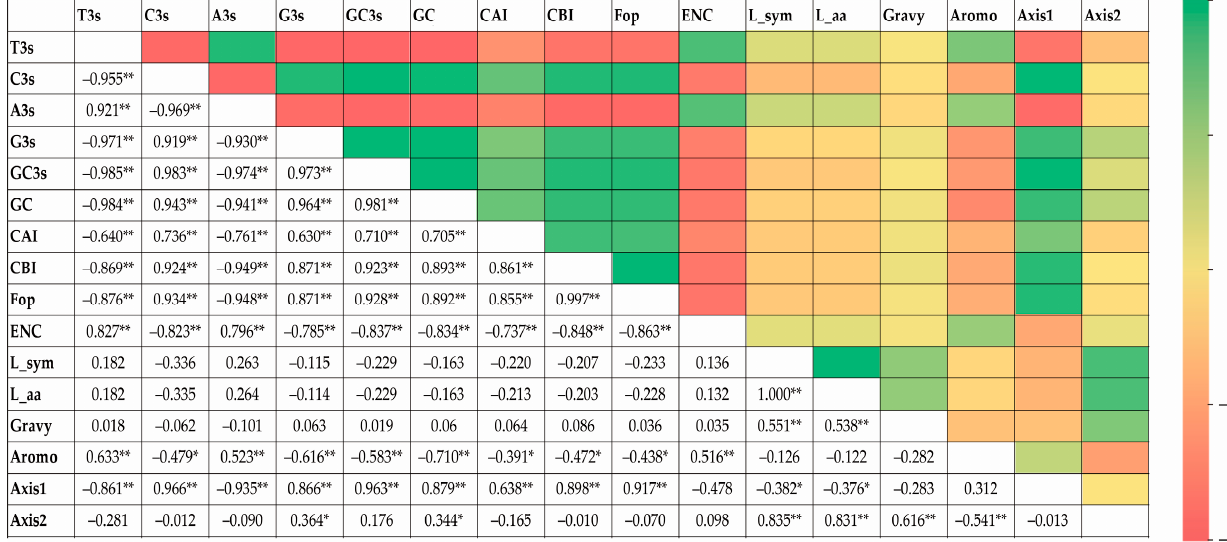
Figure 4. Correlations (r) between gene positions along the first two major axes of XET codon usage indices and synonymous codon usage bias. * means significant, ** means extremely significant.